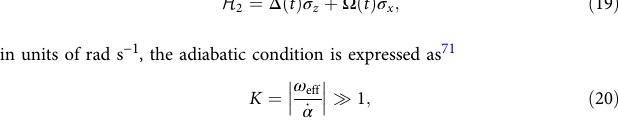
ffiffiffiffiffiffiffiffiffiffiffiffiffiffiffi p i SWAP gate that takes only